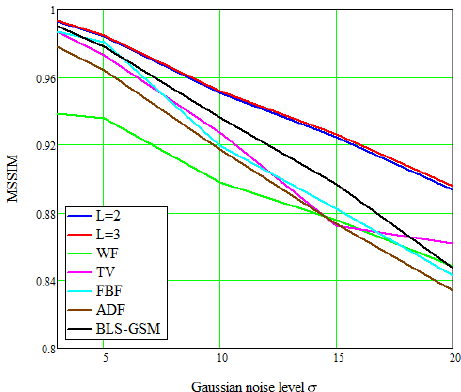
Figure 8. Comparison of measurements MSSIM of method with diffrent gaussian noise